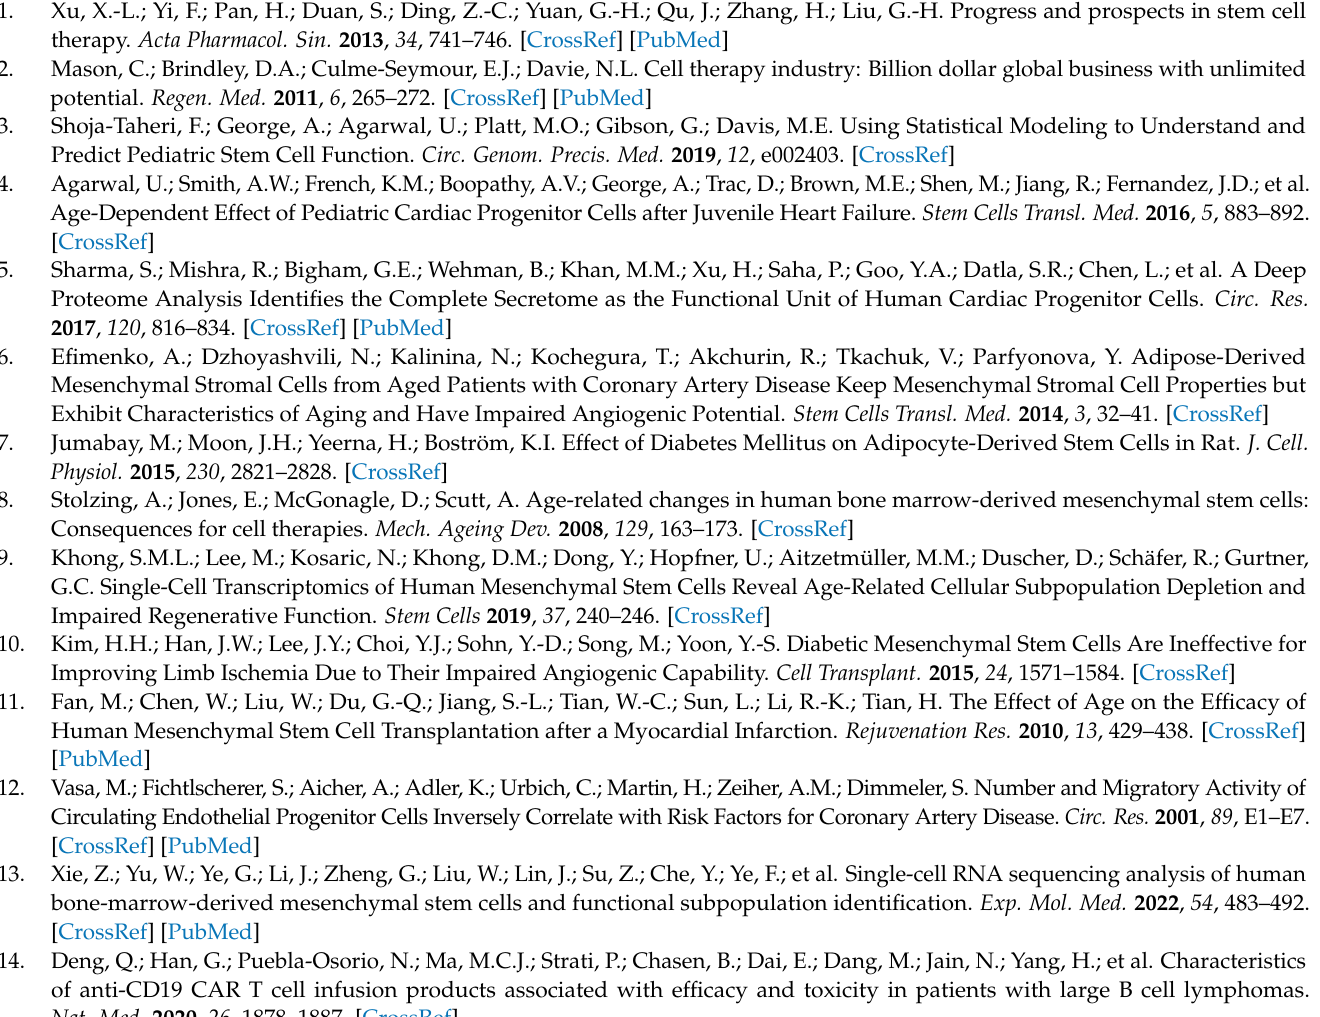
each sample. Table S3. Cell type predictions for each cluster and gene marker dataset. Table S4. Co-expressed gene modules, as determined by Monocle. Table S5. Differentially expressed genes (edgeR); Neonate vs. Child for each cell cluster. Fold-change: Neonate/Child. Table S6. Positive cluster marker gene sets for 13 cell clusters. Markers computed on non-batch corrected data using Seurat’s FindAllMarkers function and Wilcoxon rank sum method. Table S7. Metascape pathway analysis of positive cluster markers in Table S1. Values reported are − log10 ( p -value). Table S8. Top 20 genes from each age group using the quasi-poisson regression model implemented in